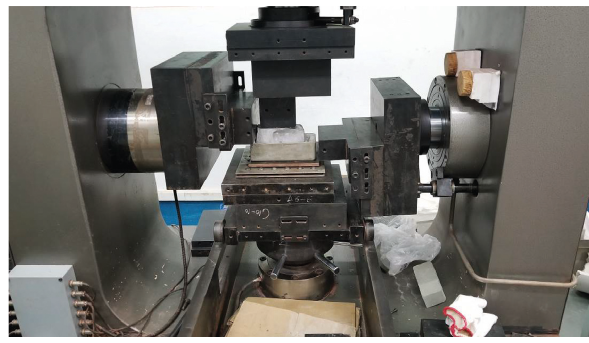
Figure 6: Rock shear rheometer. Table 2: Specifications and technical parameters of the rock shear